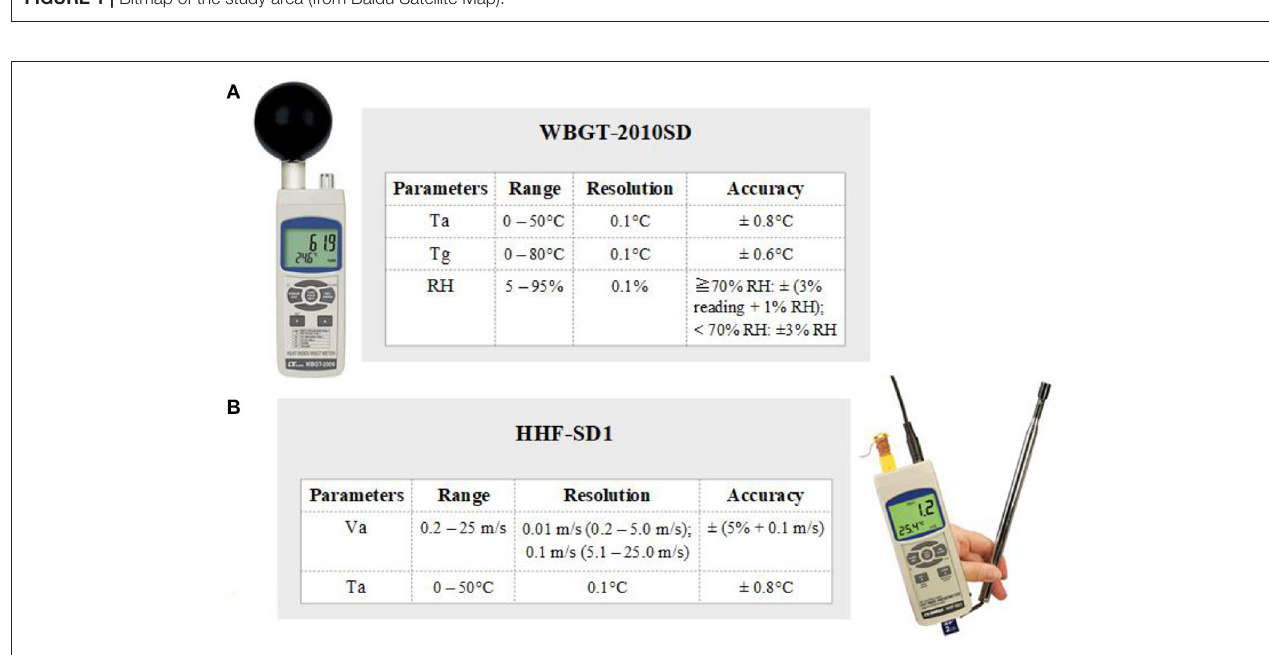
FIGURE 2 | Field measurement instruments [ (A) is a heat index WBGT measuring instrument, and (B) is an